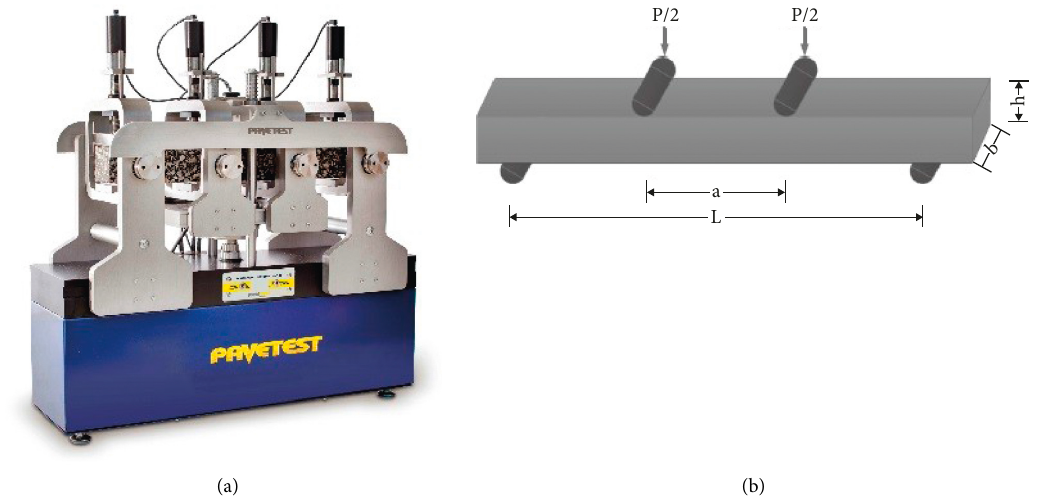
Figure 3: (a) Four-point beam fatigue test fixture and (b) illustration of fatigue test.